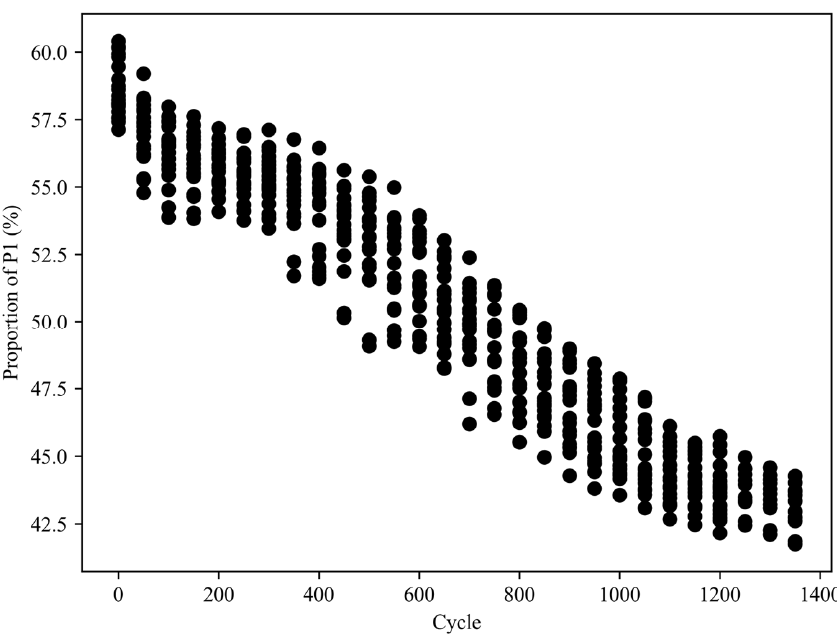
Figure 9. Proportion of the area of the P1 region of the IC curves for all cells during aging cycles.